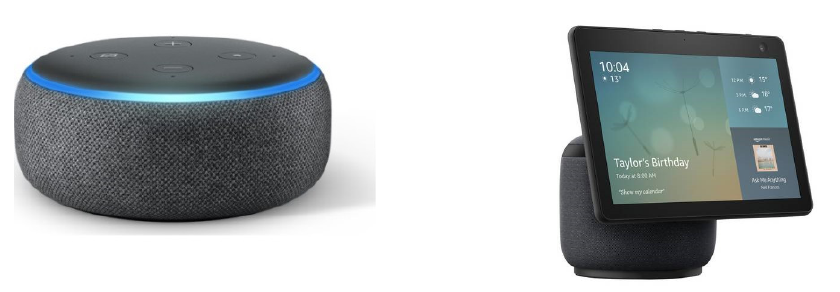
Figure 8. Alexa (https://www.amazon.co.uk/ (accessed on 11 October 2021)).